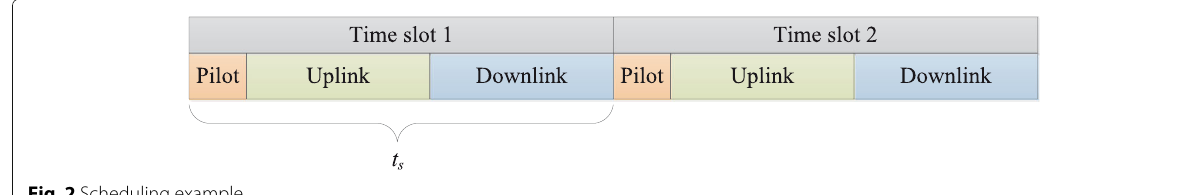
Fig. 2 Scheduling